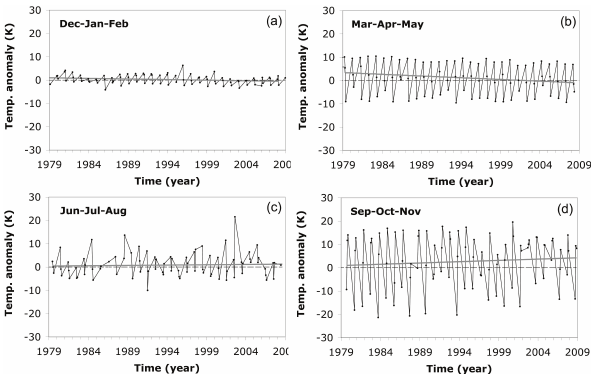
Fig. 5. Mean temperature anomalies at 20km at Dumont d’Urville between 1979 and 2008 for the three corresponding months in (a) summer, (b) autumn, (c) winter and (d) spring (one point for each month of a season, that is, three points per season). The “zero” lines are dashed and the grey lines are the estimated trend.